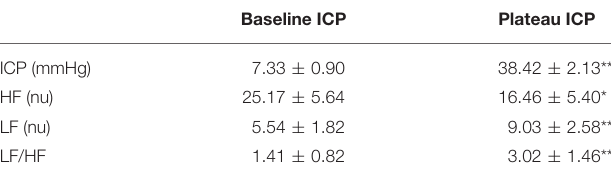
This table gives the results of heart rate variability analysis at baseline and during fluid challengeinmice:mean ± semvaluesofintracranialpressure(ICP),highfrequencypower